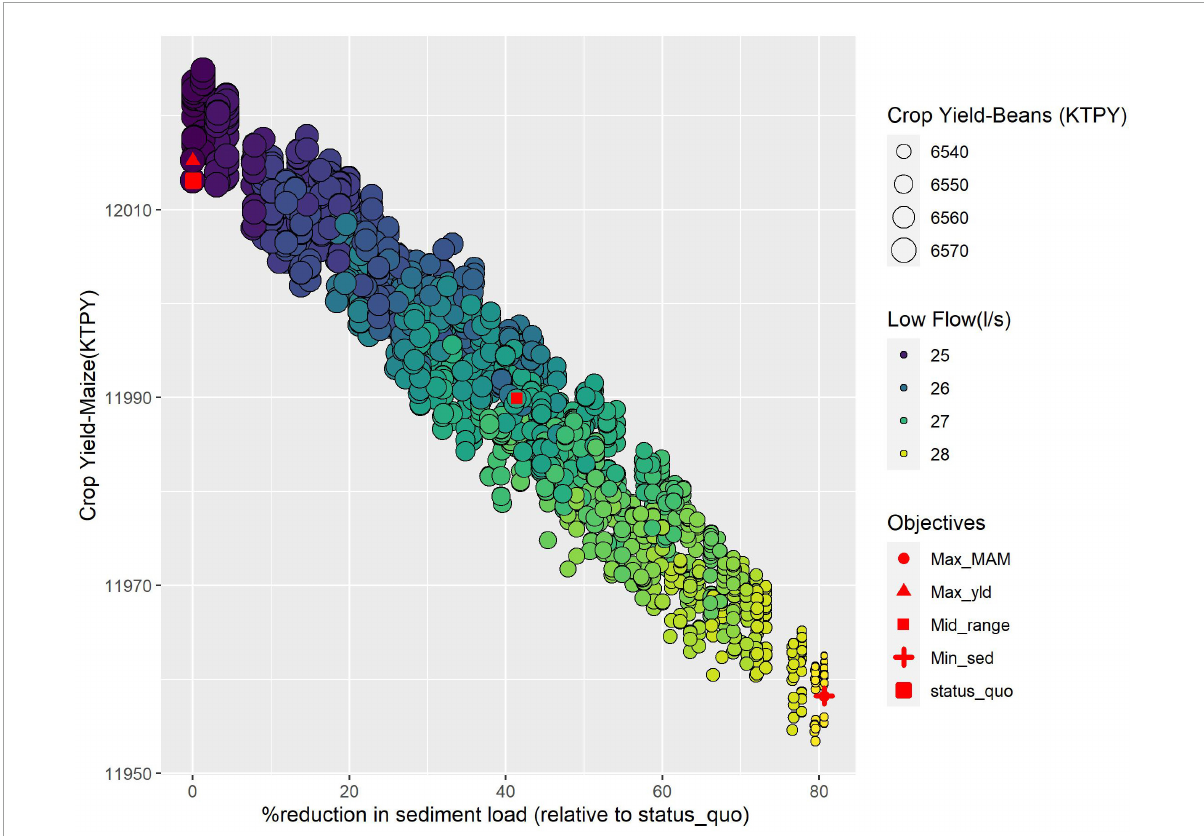
FIGURE5 Performance of the pareto solutions of scenario 3 for MAM, sediment load and crop yield objective functions.